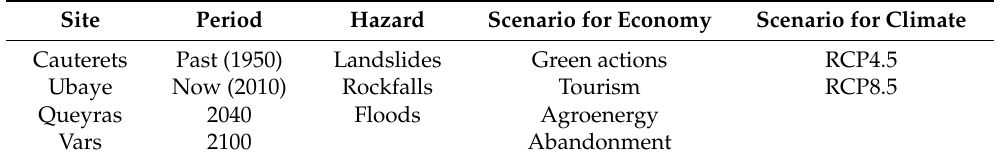
Table 2. Input parameters defining a scenario. All combinations of each parameter were almost